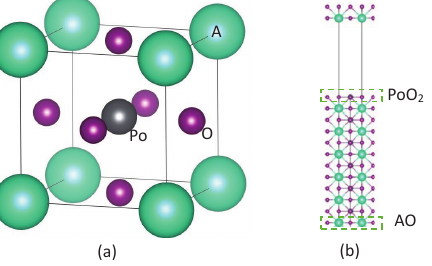
Figure 1. ( a ) Crystal structure of APoO 3 (A = Be, Mg, Ca, Sr, Ba, and Ra). ( b ) Supercell structure contains six formula units with vacuum for the surface band calculation. In a normal supercell, there are PoO 2 and AO surfaces on opposite sides. To investigate which surfaces give rise to the contributions on conduction bands, we prepared two kinds of supercells. One has PoO 2 surface on both sides, i.e., bottom AO layer is removed, and the other has AO surfaces on both sides, i.e., remove the top PoO 2 layer.